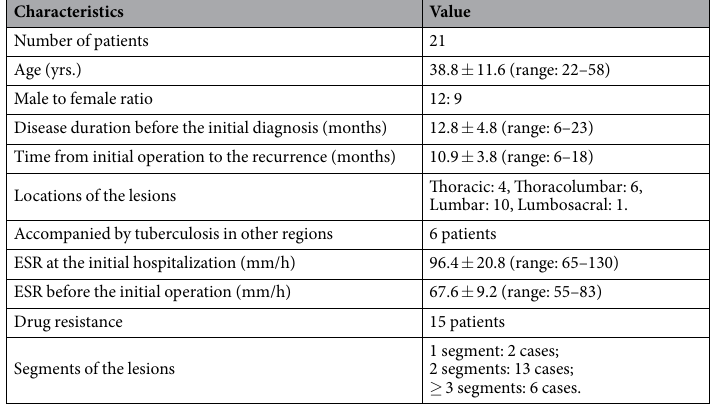
Table 1. Demographic and clinical characteristics of the recurrent patients. ESR: erythrocyte sedimentation rate. Data are presented as the mean ± standard